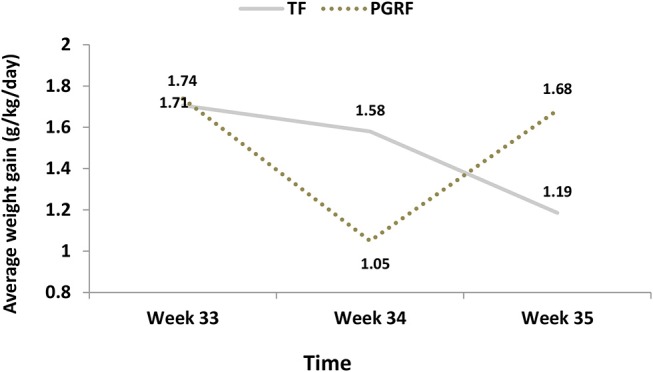
Average weight gain (g/kg/day) among the study groups. PGRF, parental guided responsive feeding; TF, traditional feeding. Analysis was based on repeated measure analysis with Bonferroni correction for time effect. Three main effects were tested:1. Effect for Time F(2, 126) = 7.202 p = 0.001, partial eta-squared (ηp2) = 0.103 (10.3%). After Bonferroni correction the significant differences were found between week 33 to week 34 (p = 0.002) and week 35 (p = 0.023), but not between week 34 to week 35 (p = 0.875).2. Effect for group F(1, 63) = 0 p = 0.993, partial eta-squared (ηp2) = 0.000 (0%)3. Interaction effect (Time*Group) F(2, 126) = 10.921 p < 0.001, partial eta-squared (ηp2) = 0.148 (14.8%).[The effect sizes express the amount of variance accounted for by one or more independent variables].